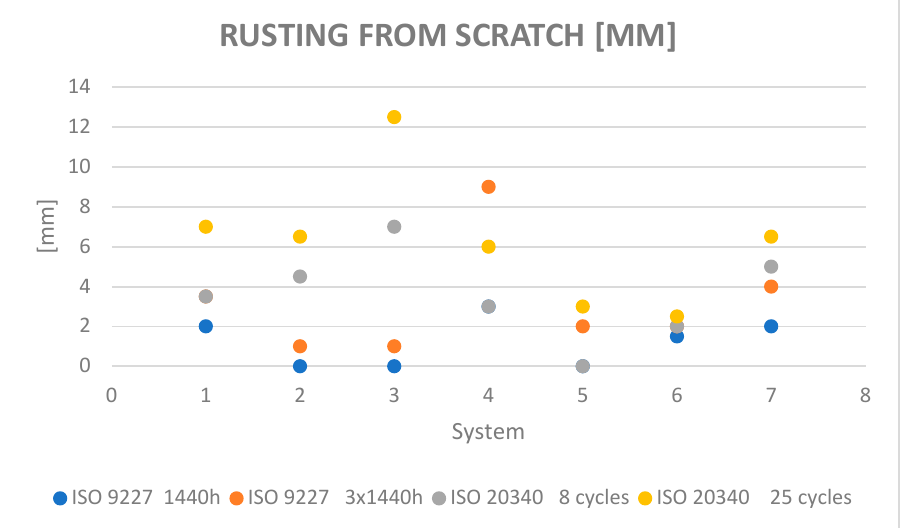
Figure 6. Blistering from the scratch measured according to ISO 4628 ‐ 8:2012 [8]. Figure 7 shows an example of the appearance of the coatings without the scratch after 4320 h of salt spray testing. The same is true for the other systems and tests, where no differences were found between the results for flat and T ‐ shaped plates. The appearance of A and B system coatings with scratches after 4320 h of exposure in a salt spray chamber are presented in Figure 8.